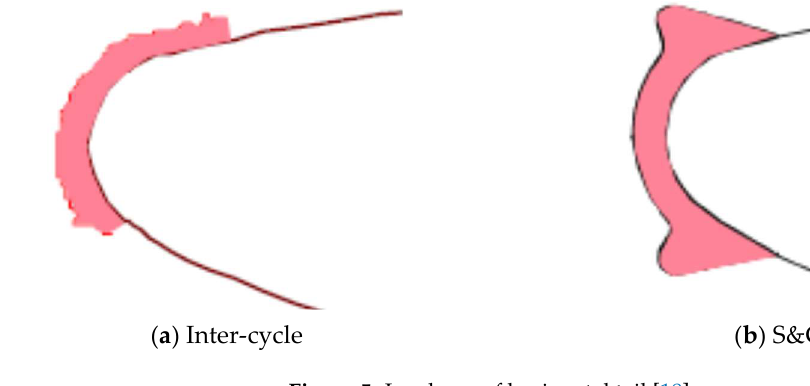
Figure 5. Ice shape of horizontal tail [18].